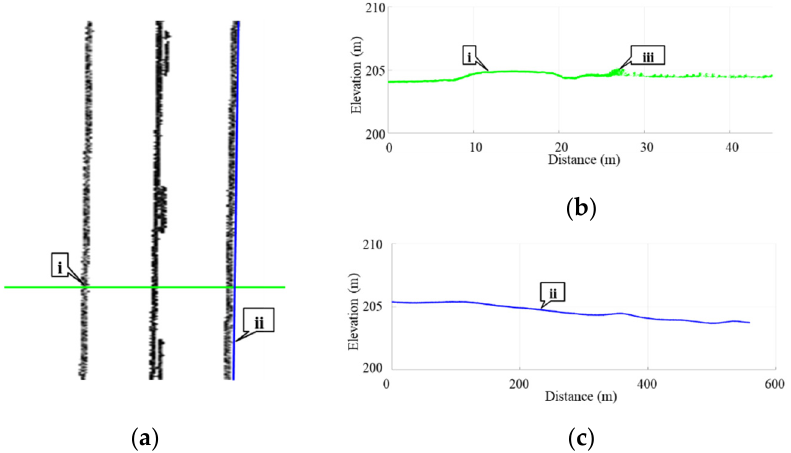
Figure 17. Pilot mobile mapping system data acquisition: ( a ) intensity profile from single sensor pilot mobile mapping system; ( b ) LiDAR cross-section; ( c ) LiDAR longitudinal pavement marking profile.